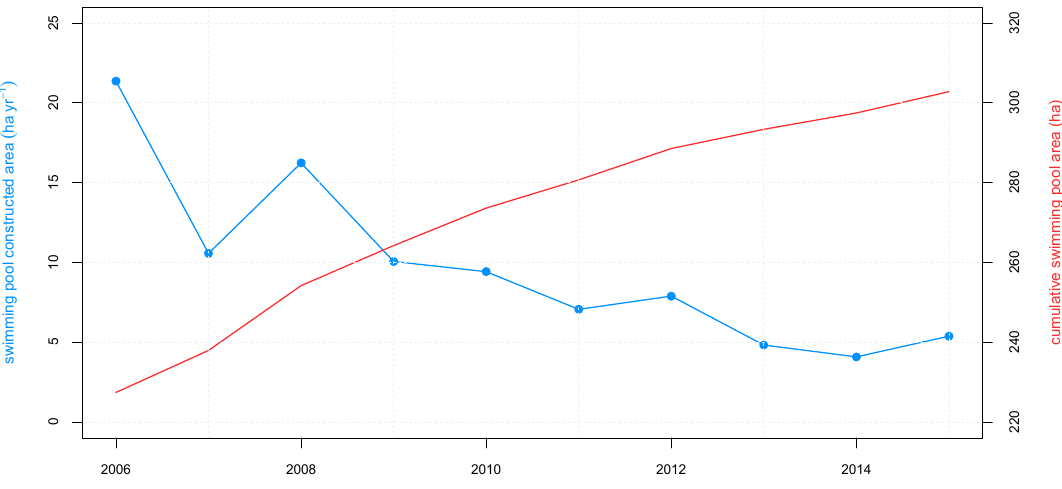
Figure 6. Evolution of swimming pool surface area in the Balearic Islands over a decade (2006 to 2015).